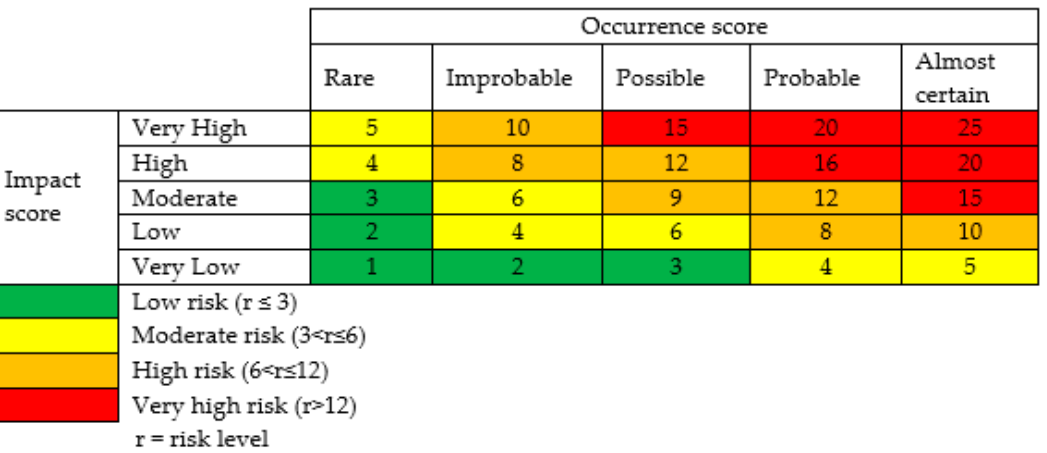
Figure 2. Risk matrix. Source: adapted from [21].